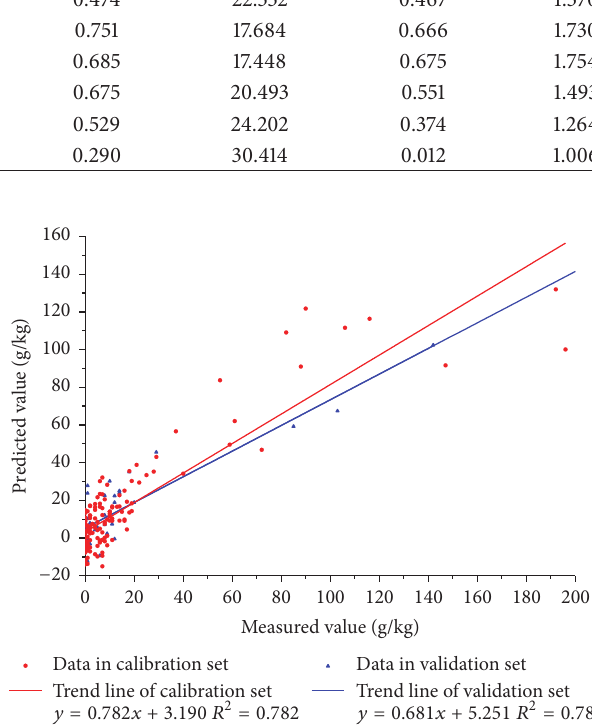
Figure 6: The relationship between measured and predicted soil salt content in calibration and validation